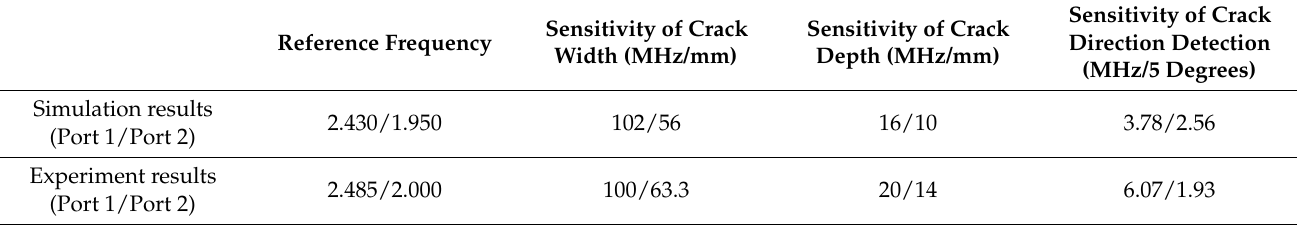
Figure 17. Measured reflection coefficient results of fabricated sensor for crack with different direc- tions. ( a ) Port 1. ( b ) Port 2. Table 2. Comparison of results of simulation and experiment.